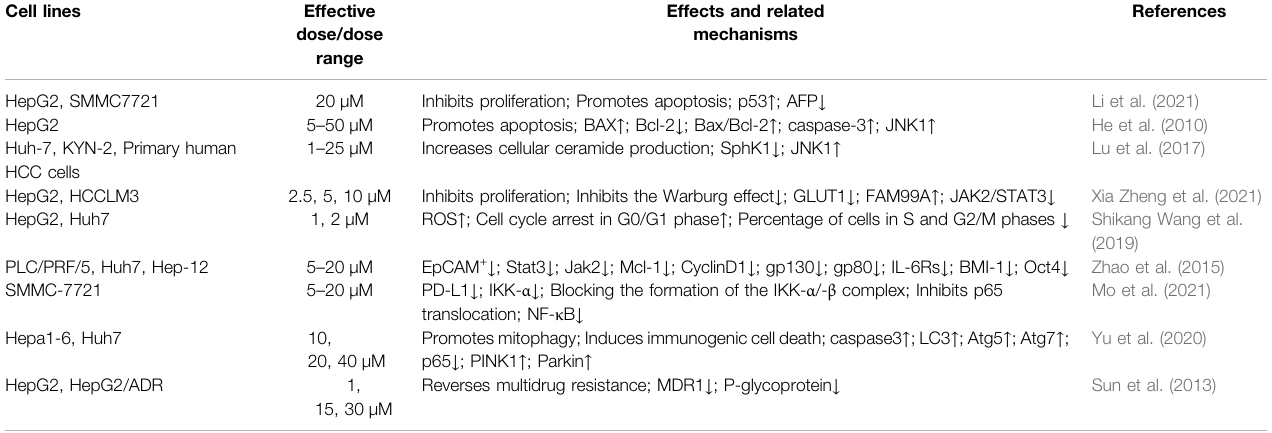
TABLE 4 | In vitro effects of icaritin on liver cancer cells and the underlying mechanisms.